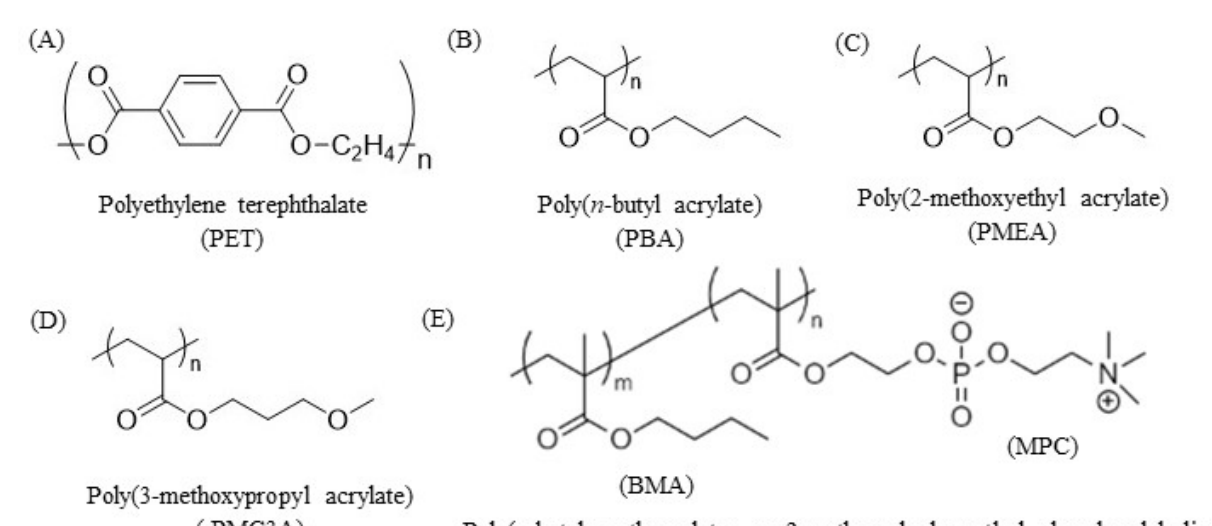
Figure 1. Chemical structure of ( A ) polyethylene terephthalate (PET); ( B ) poly( n -butyl acrylate) (PBA); ( C ) poly(2-methoxyethyl acrylate) (PMEA); ( D ) poly(3-methoxypropyl acrylate) (PMC3A), and ( E ) poly( n -butyl mathacrylate- co -2-methacryloyloxyethyl phosphorylcholine) (BMA 70 mol%, MPC 30 mol%) (PMPC).